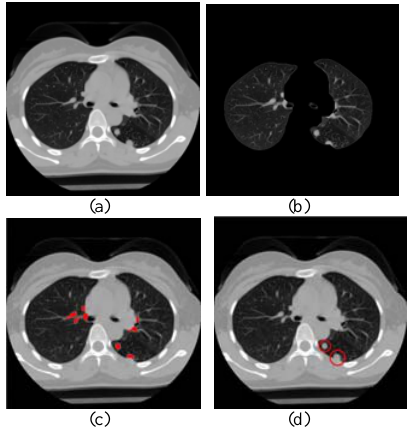
Fig. 11. Recognition results of the case containing a solitary nodule and an adhesive nodule. (a)CT original image, (b) Lung parenchyma segmentation, (c) ROIs extraction, (d) classification Results.